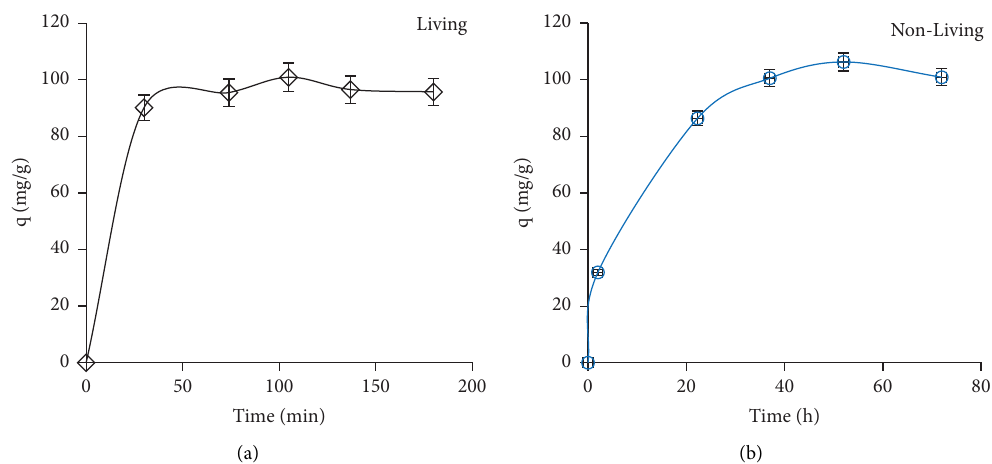
Figure 5: Efect of time on Pb (II) uptake by Penicillium notatum in living (a) and nonliving state (b) (pH: 5).